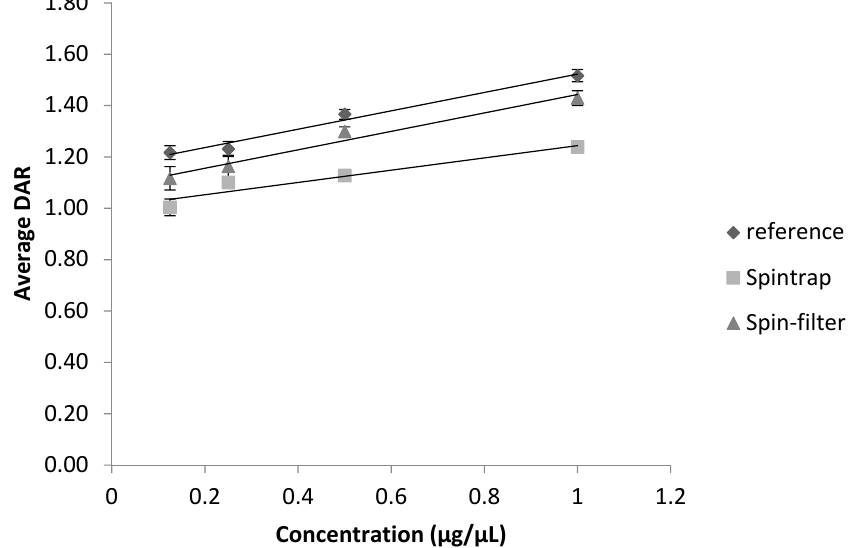
Figure 4. Apparent DAR-values of DM1–trastuzumab depending on sample concentration prior to injection and effect of sample desalting Error bars depict the standard deviation from triplicate measurements for each sample.